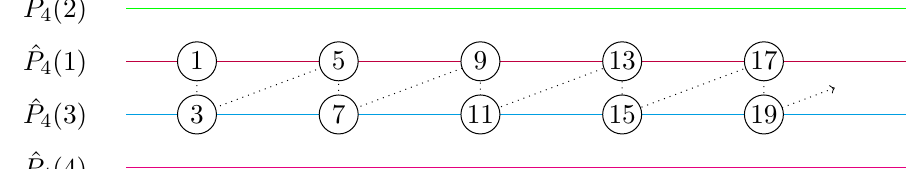
Figure 6 . Periodicity of the function P α ( n ) for α = 4 , with odd argument n ∈ 2 N 0 +1 . Each circle contains increasing odd integers n = 2 l + 1 , while the horizontal lines represent the corresponding value P ( n ) . The periodicity P ( n ) = P ( n mod 4) necessarily leaves out half of the possible values 4 4 4 ˆ P α ( k ) in the first column. Even arguments n ∈ 2 N 0 behave in the same way for odd values of α